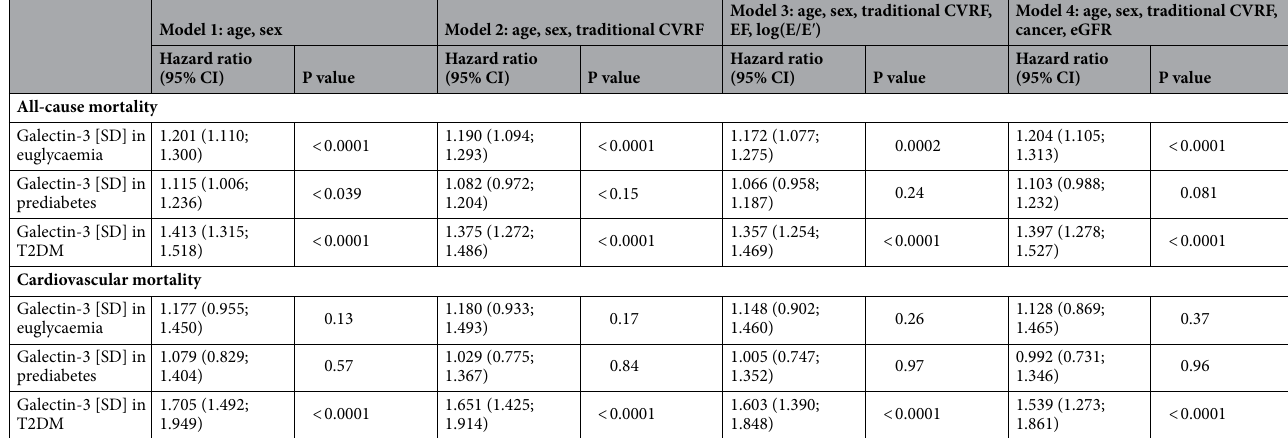
Table 4. Association between galectin-3 and cardiovascular as well as all-cause mortality in prediabetes and type 2 diabetes mellitus. Cox regression models for investigation of the association between galectin-3 (increase per standard deviation respectively 5 ng/ml) and cardiovascular as well as all-cause mortality in prediabetes and diabetes compared to euglycaemia. Model 1 adjusted for sex and age; n = 14,783; CV mortality events = 108; all-cause mortality events = 837. Model 2 adjusted for sex, age, hypertension, dyslipidaemia, obesity, smoking, FH of MI/stroke. n = 14,733; CV mortality events = 107; all-cause mortality events = 830. Model 3 adjusted for sex, age, hypertension, dyslipidaemia, obesity, smoking, FH of MI/stroke, EF, log(E/E ′ ). n = 14,561; CV mortality events = 106; all-cause mortality events = 817. Model 4 adjusted for sex, age, hypertension, dyslipidaemia, obesity, smoking, FH of MI/stroke, cancer, eGFR. n = 14,721; CV mortality events = 107; all-cause mortality events = 829. EF ejection fraction, eGFR estimated glomerular filtration rate, CVRF cardiovascular risk factors, FH of MI/stroke family history of myocardial infarction or stroke, SD standard deviation, T2DM type 2